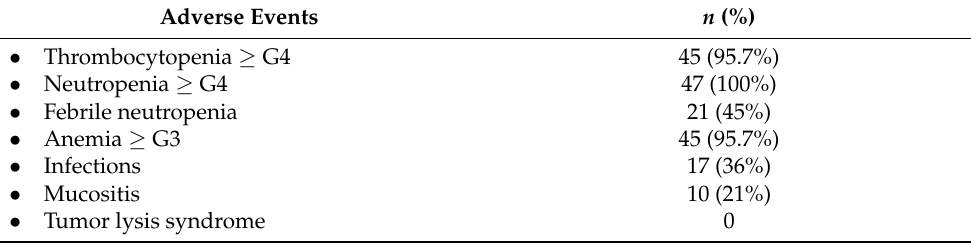
Table 3. Adverse